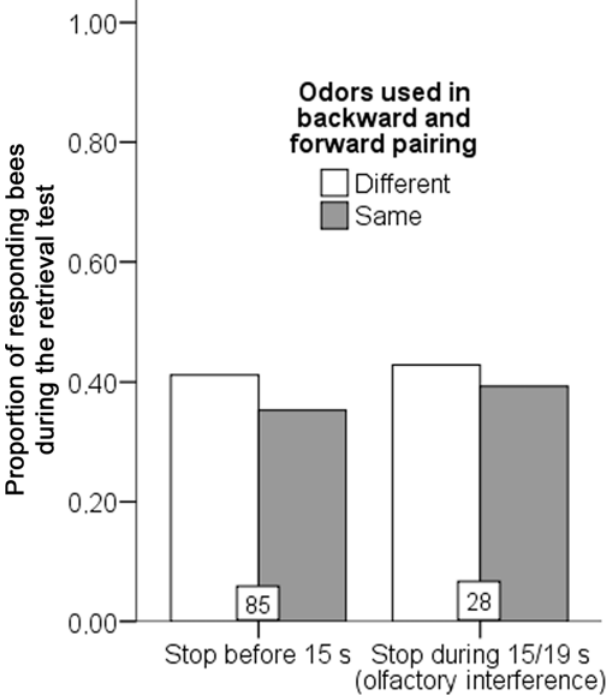
Figure 5. Effect of a backward pairing with one odor on the response to this odor and another odor. Performance of the bees during a retrieval test. This test was performed 3 hours after a single trial with each of two odors, one having been used in a previous backward pairing for olfactory interference (‘‘same’’) and the other being a novel odor (‘‘different’’). The bars are presented as a function of the behavior of the bees during the backward pairing. The boxes at the base of each bar indicate the sample size. Three bees only extended their proboscis beyond 19 seconds, so they are not represented here.